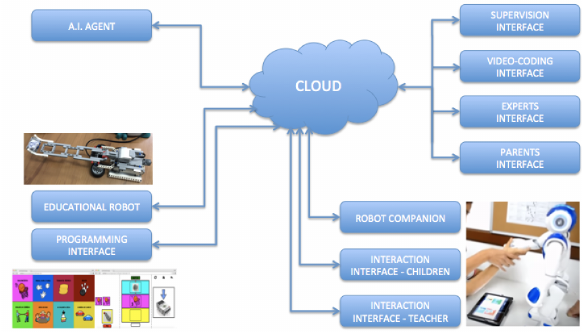
Figure 3: Cloud robotics ecosystem for the “Data Analysis and Col- lection through Robotic Companions and LEGO® Engineering with Children on the Autism Spectrum”